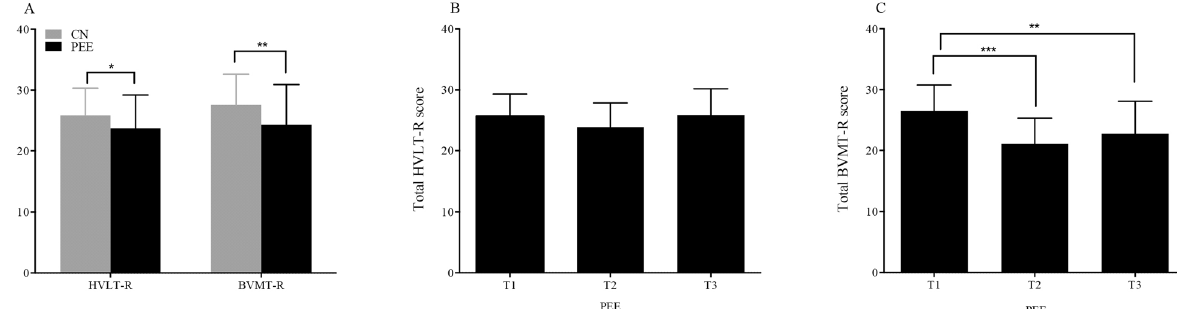
Fig. 4 Box of total scores of HVLT-R and BVMT-R prenatal earthquake exposure and control groups. A The signi fi cant lower scores of both HVLT-R and BVMT-R were found between two groups. B No signi fi cant difference was found that compared the total BVMT-R scores among the subgroups of PEE group. C The second trimester of PEE group was showed a remarkedly lower compared to the fi rst trimester or third trimester. PEE prenatal earthquake exposure group, T1 fi rst trimester, T2 second trimester, T3 third trimester, HVLT-R Hopkins Verbal Learning Test-Revised, BVMT-R Brief Visuospatial Memory Test-Revised. * p < 0.05, * * p < 0.01, * ** p < 0.001.